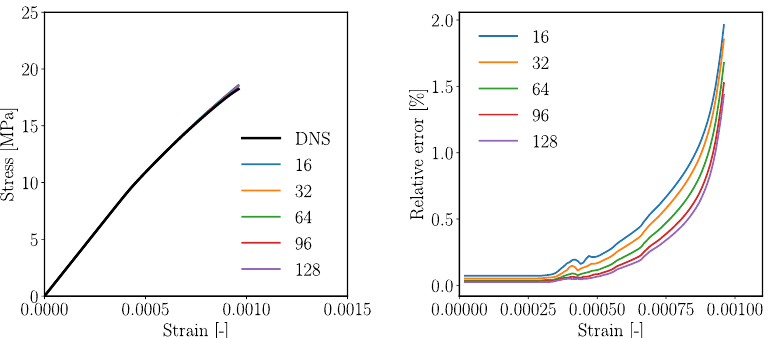
Figure 8. Performance of the k-means-based reduced order scheme in numerical analyses of a simple microstructure subjected to uniaxial compression according to Figure 6. Left: stress–strain curves obtained from five different k-means based models, right: Relative error (measured w.r.t. the direct numerical simulation) of the computed axial stress obtained for a different number of clusters.